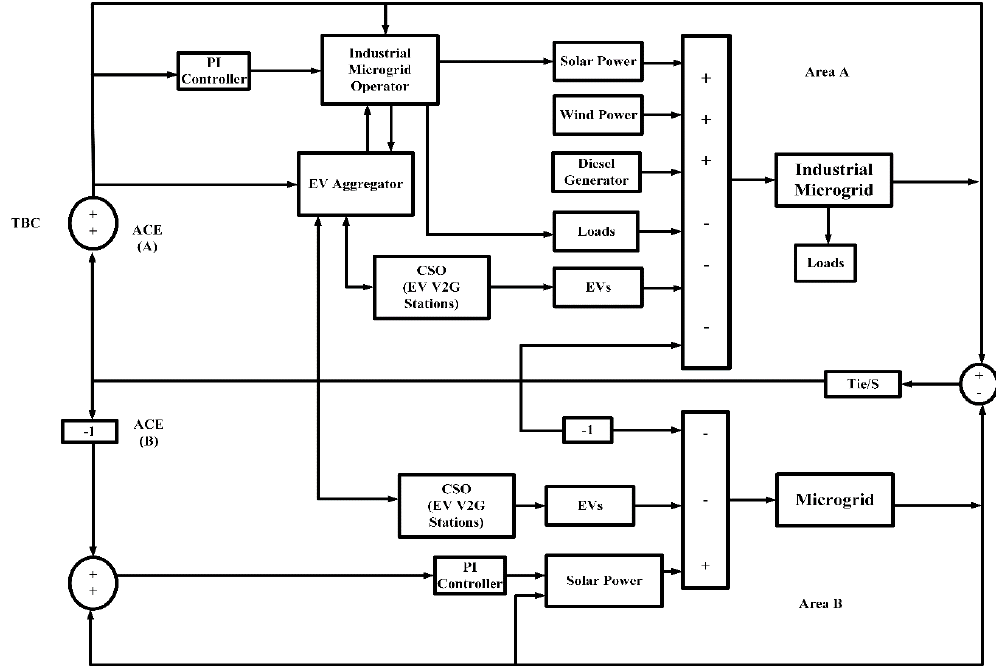
Figure 7. Simulation network of industrial microgrid for the PFC with EVs.